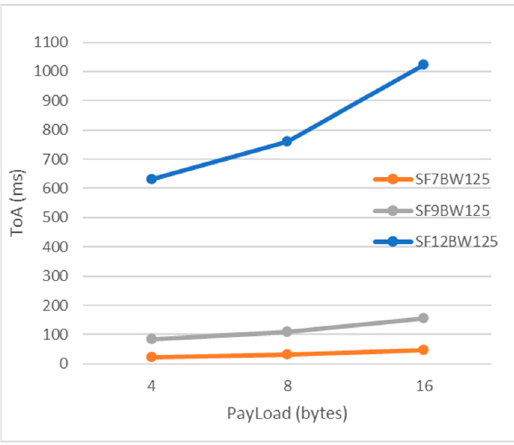
Figure 17. LoRa data packet transmission time.